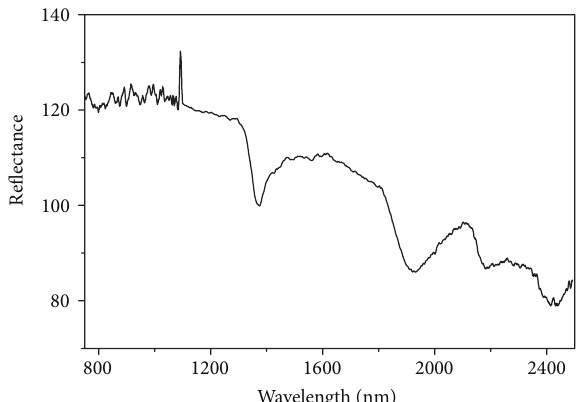
Figure 6: NIR spectrum of annealed MgO nanoparticles prepared by combustion followed by annealing